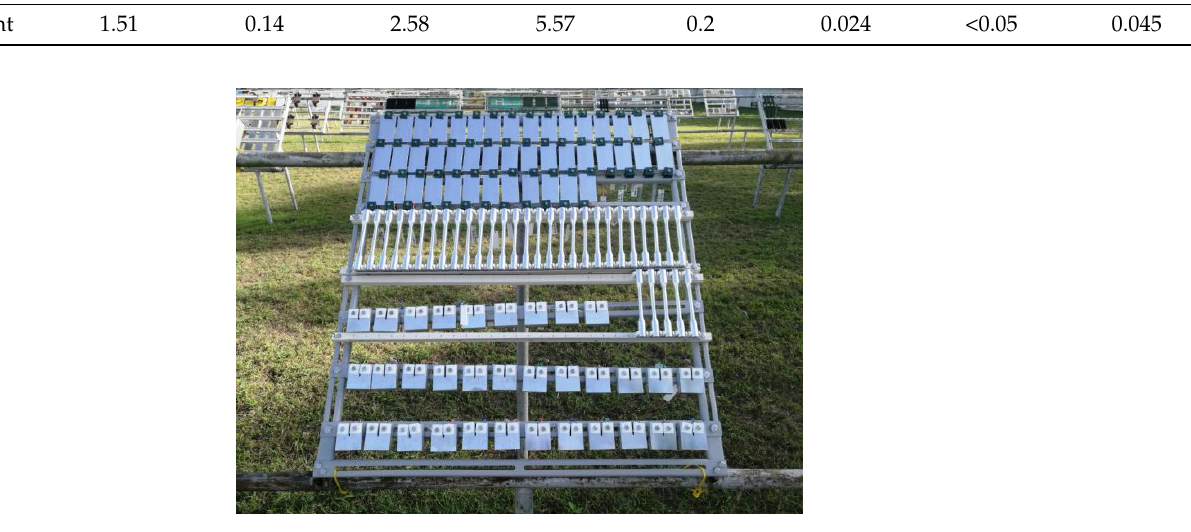
Figure 1. Outdoor exposure test of the 7075 alloy in the marine atmospheric environment.